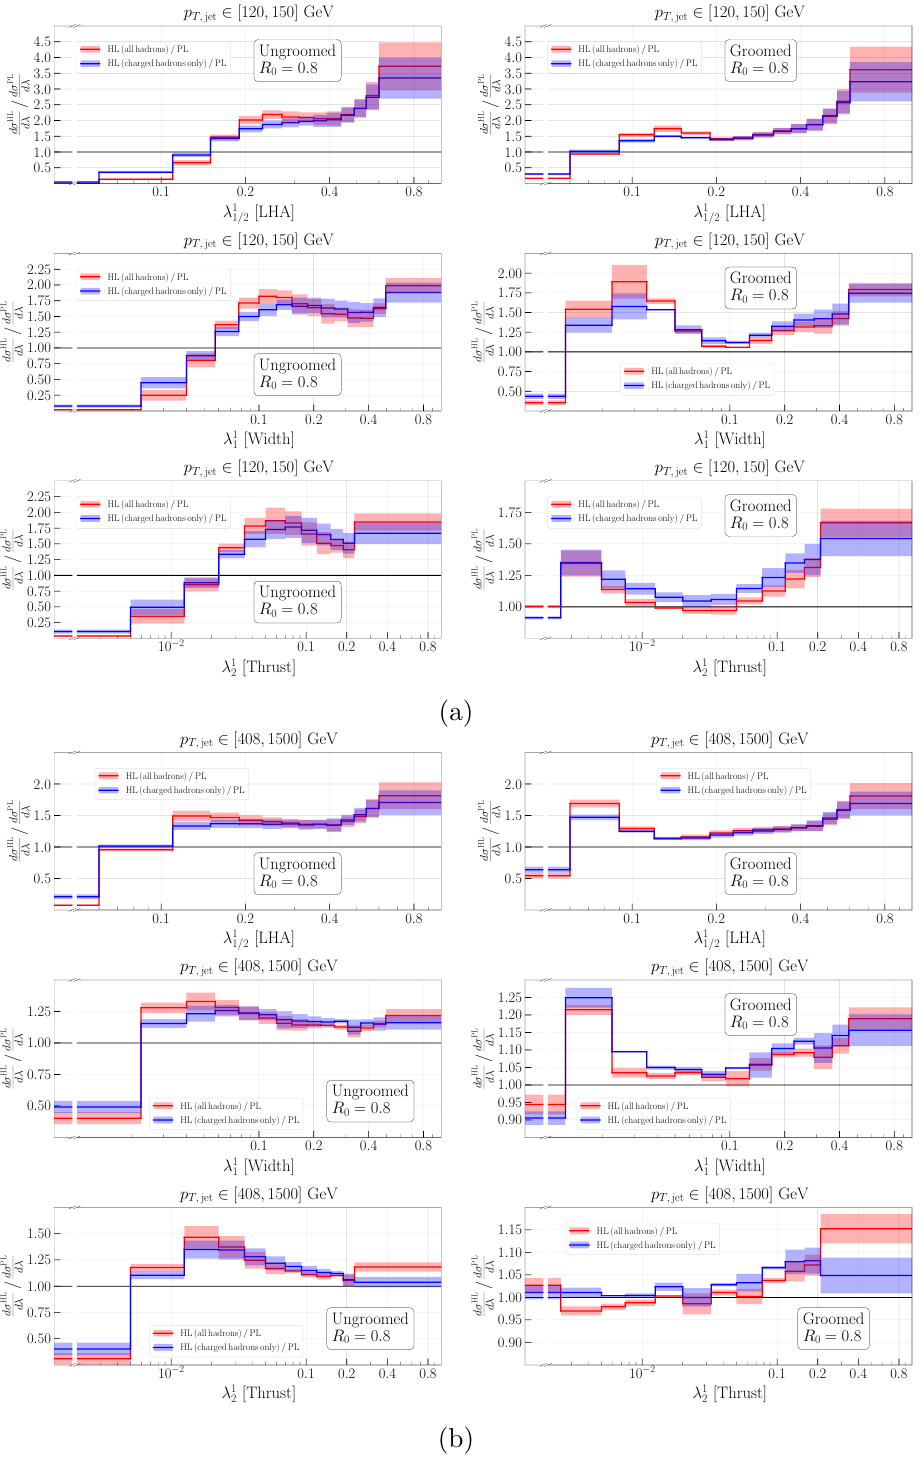
Figure 12 . Hadron-to-parton-level ratios with associated uncertainties extracted from MC simu- lations. Results are provided for jet angularities based on all hadrons, and charged hadrons only, for p T, jet ∈ [120 , 150] GeV (a) and p T, jet ∈ [408 , 1500] GeV